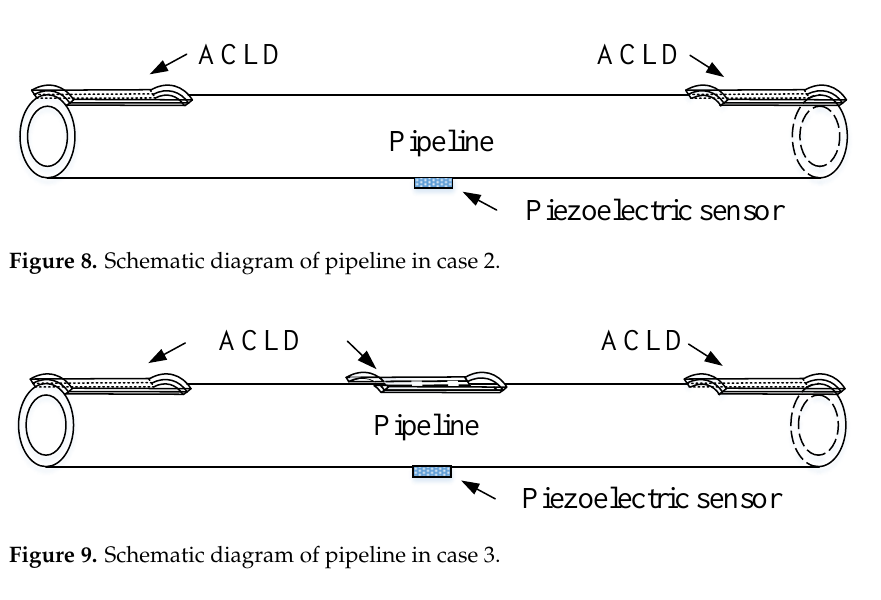
Figure 7. Influence of ACLD length on the ( a ) natural frequency and ( b ) loss factor.